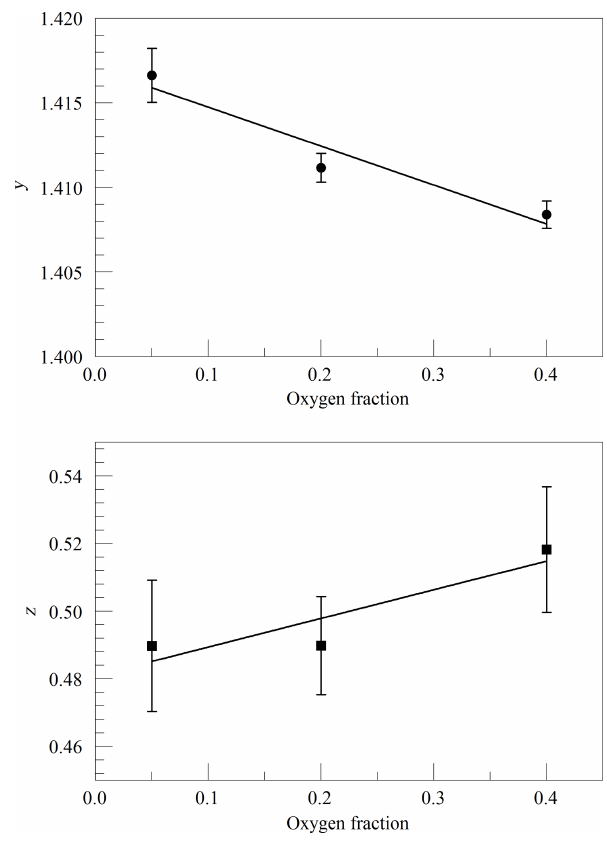
Figure 3. Galatry parameters of the Q13Q13 line of O 2 at 340hPa and 45 ◦ C as a function of the O 2 mole fraction in binary O 2 –N 2 mixtures. The linear fits to the data are y = 1 . 417 − 0 . 023 × f O and z = 0 . 481 + 0 . 085 × f O . 2